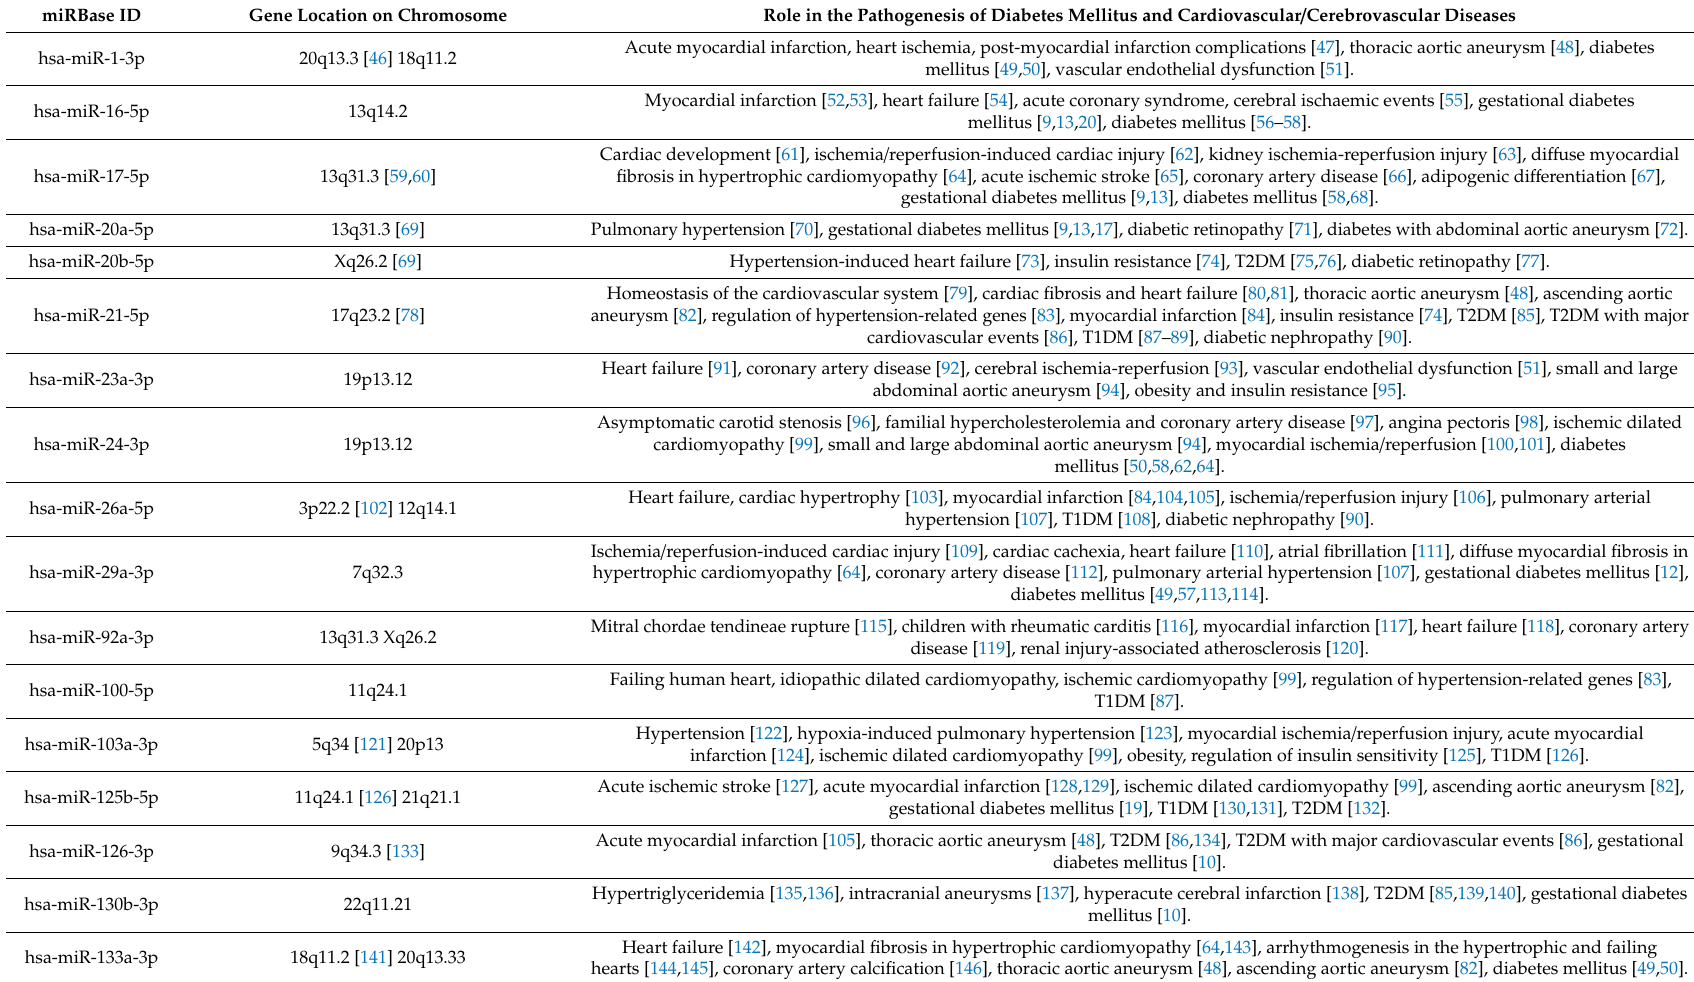
Table 1. The role of studied microRNAs in the pathogenesis of diabetes mellitus and cardiovascular / cerebrovascular